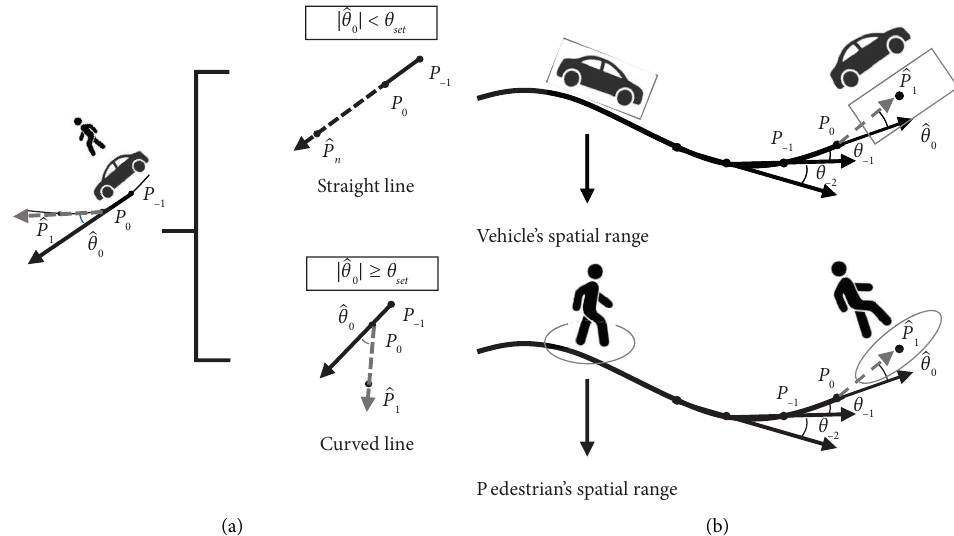
Figure 4: Trajectory prediction method: (a) trajectory classifcation—straight and curved trajectories are classifed based on whether the angle of the previous trajectories is smaller than the angle predetermined. (b) Trajectory predictions—vehicle and pedestrian trajectories are predicted as rectangles and ellipses, considering the actual vehicle size and stochastic pedestrian trajectories, respectively.